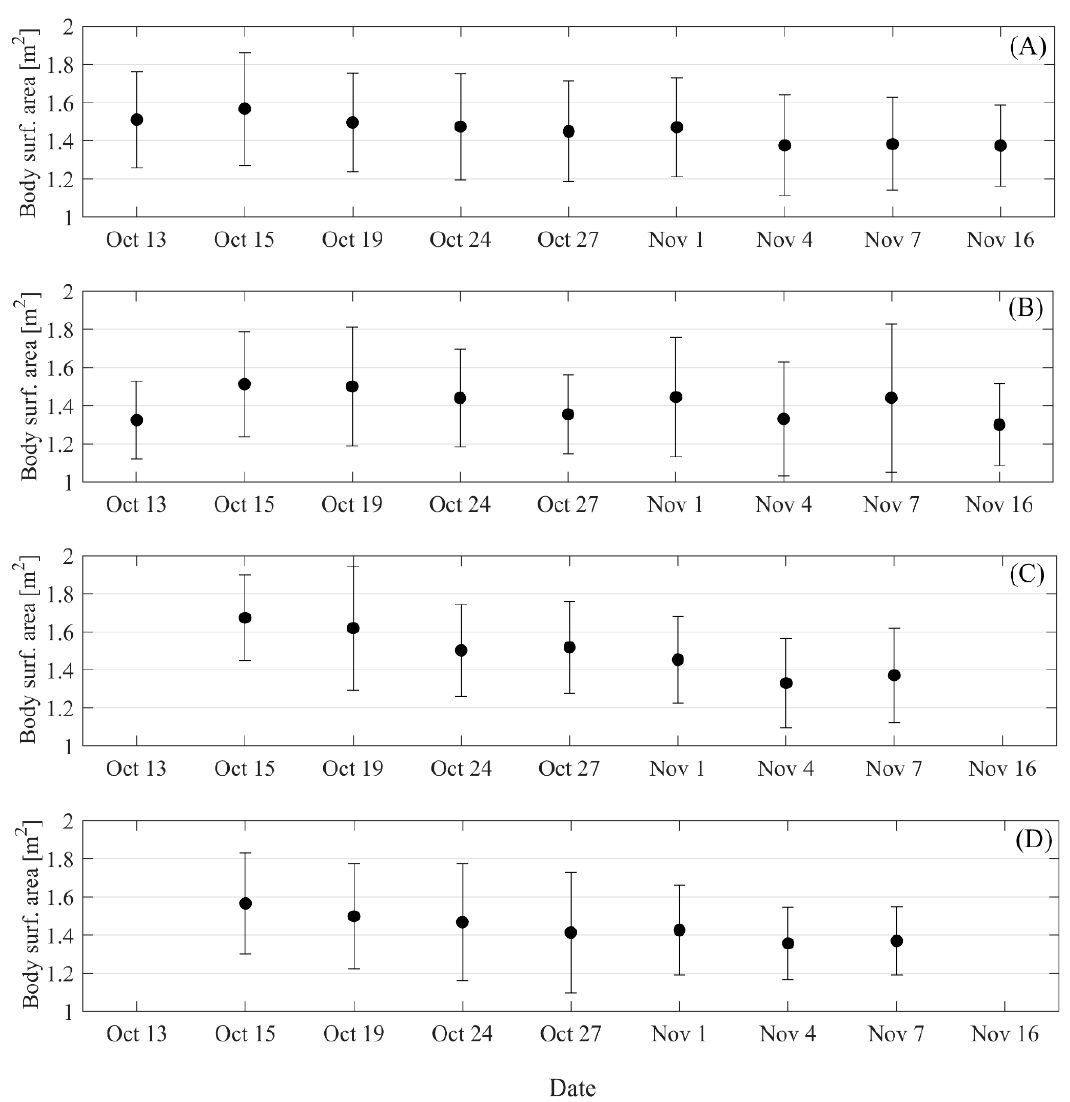
Figure 9. Average body surface area with one standard deviation (whisker) for Zone I ( A ); Zone II ( B ); Zone III ( C ); and Zone IV ( D ).